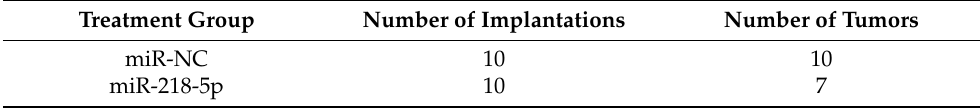
Figure 4. MiR-218-5p inhibited As-T cells-induced tumor growth and angiogenesis and decreased EGFR expression in vivo. ( A ) Stable As-T cell lines containing overexpressed miR-218-5p or miR-NC by transducing lentivirus and selecting puromycin. TaqMan real-time PCR was used to detect miR- 218-5p expression. ( B ) As-T cells at 2 × 10 6 overexpressing miR-NC or miR-218-5p subcutaneously injected into both flanks of nude mice (5 mice/group receiving 10 injections). Tumor size was measured every three or four days when tumors were visible. After 28 days of injection, mice were sacrificed, and tumor tissues were trimmed out. ( C ) Photograph exhibited xenografts obtained from the miR-NC and miR-218-5p groups. ( D ) Tumor weight from each group. ( E ) Expression of miR-218- 5p, FLT1, FLT4, and KDR in the tumor tissues. ( F ) EGFR expression in tumor tissues from the miR-NC and miR-218-5p groups. ( G ) Number of CD31 positive microvessels by immunohistochemical staining assay, which was normalized by the miR-NC control group. Data were shown as means ± standard error. * p < 0.05, ** p < 0.01, *** p < 0.001 compared to the miR-NC group. The original western blots of this figure is Figure S8. Table 1. Tumor formation in vivo.